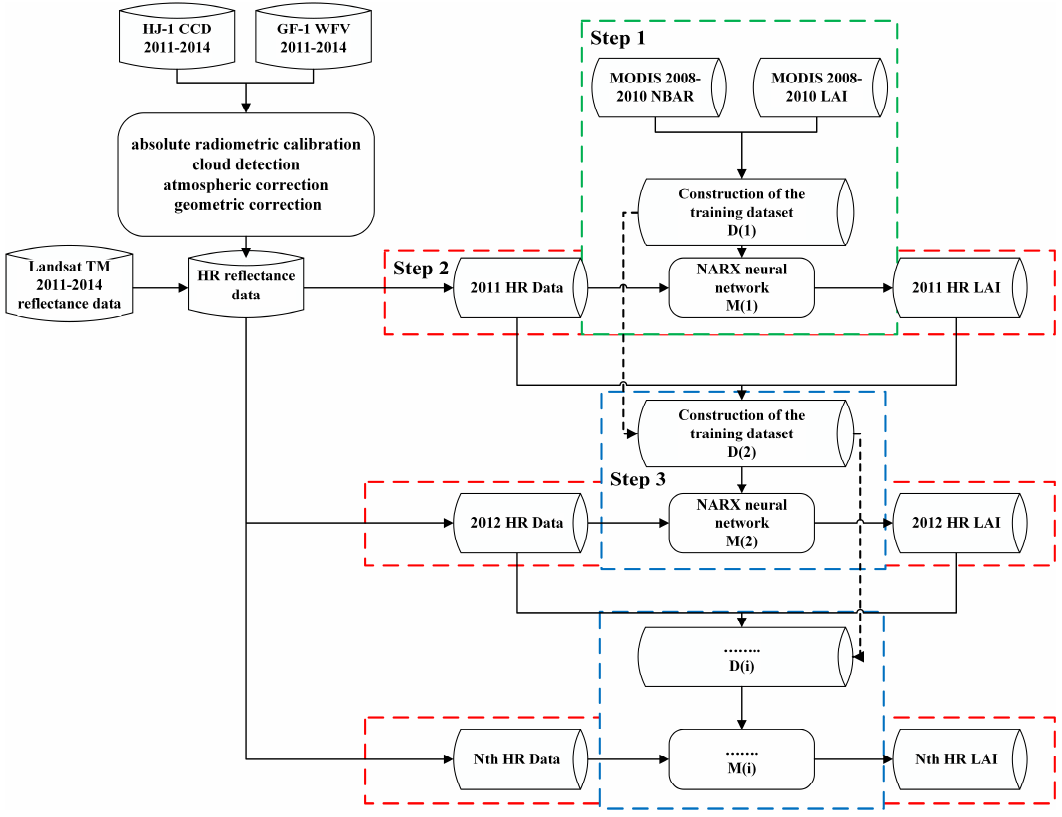
Figure 1. A flowchart for the Nonlinear Auto-Regressive with Exogenous Inputs (NARX) network- based recursive update model to estimate Leaf area index (LAI). D and M in the plots stand for training data and the NARX network, respectively. (1), (2), ...(i) represent the training step number. The green dotted box represents step 1. The red dotted box represents step 2. The blue dotted box represents step 3.